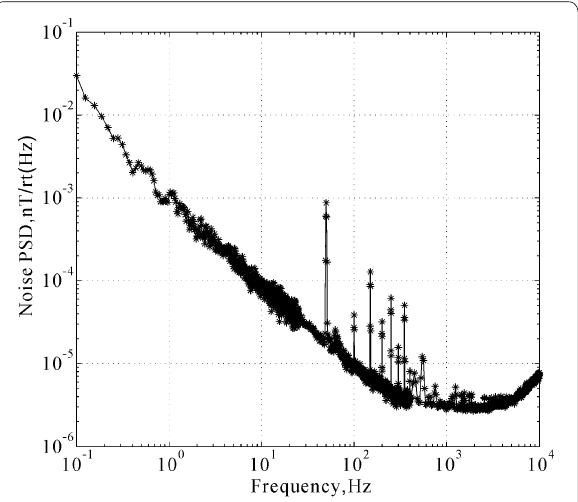
Fig. 8 Self-noise level of the induction coil. The induction coil sen- sor noise level is measured in a magnetically shield room using a dynamic signal analyzer Agilent 35670A. The noise level is approxi- mately 1 pT/ √ Hz at 1 Hz. There is 1/f noise in the 1000 to 0.1-Hz frequency band, and in the nearby band of 1000-Hz frequency, the noise level is flat. Peaks at 50 Hz and its harmonics are clearly observed because of the ambient 50-Hz noise. This is because the magnetically shield room was not very “clear”